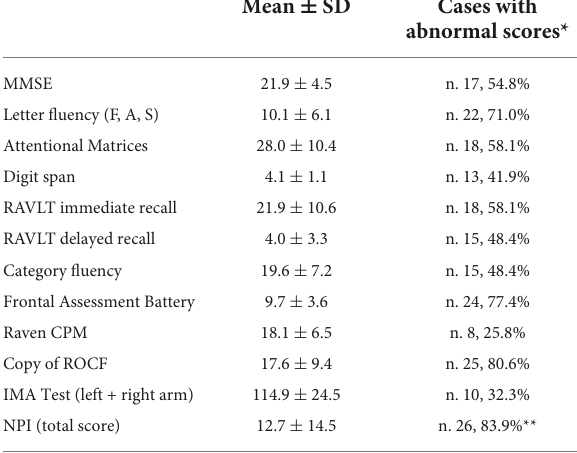
TABLE 2 Neuropsychological profile of the PSP sample and performance of the Letter fluency test. Mean ± SD Cases with abnormal